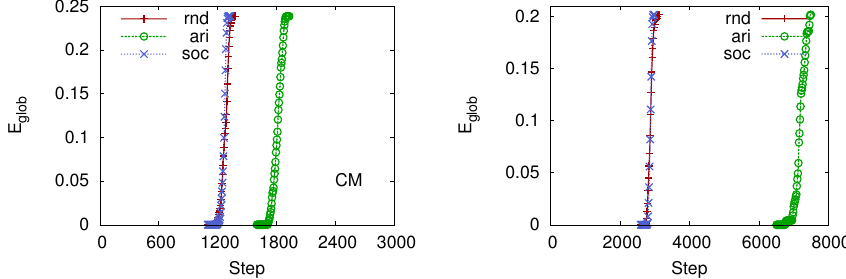
Figure 8. Effect of parallel network simulation for Communities ( left panel ) and VirtualTourist ( right panel ). These plots help us to understand how parallel links’ creation modifies the dynamics of online social systems. Surprisingly, preferential attachment (that outperforms other rules in inertial setting) is the slowest, obtaining bad performance in terms of time needed to reach the target efficiency. Curves start at simulation time t 0 , but we cropped the points for low values of E glob for graphical clarity. Standard deviations are very small and are not plotted for graphical reasons.